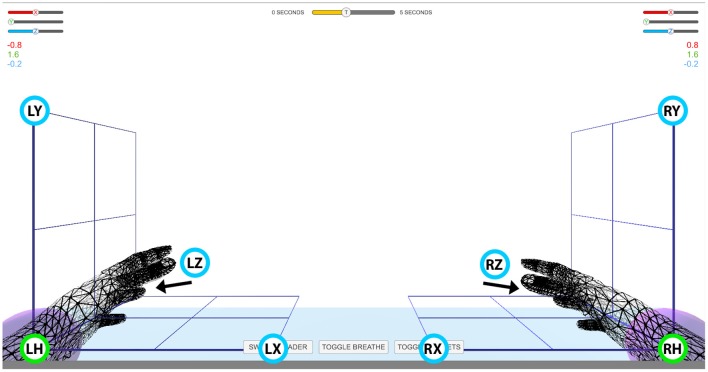
Virtual arm layout. Experimental setup for controlling virtual arms in 3D space. Green circles with labels LH and RH denote left and right home position, respectively. Blue circles with labels LX, LY, LZ and RX, RY, RZ denote target positions for the left (L) and right (H) hand in the horizontal (X), vertical (Y), and depth (Z) planes, respectively. The movement of the virtual arms was restricted to an area indicated with the cubic grid. The numbers above the grid on the left and right side of the screen indicate Cartesian coordinates of the virtual arm. The slider bars above the Cartesian coordinates and the time indicator bar at top of the screen were not used in this study.